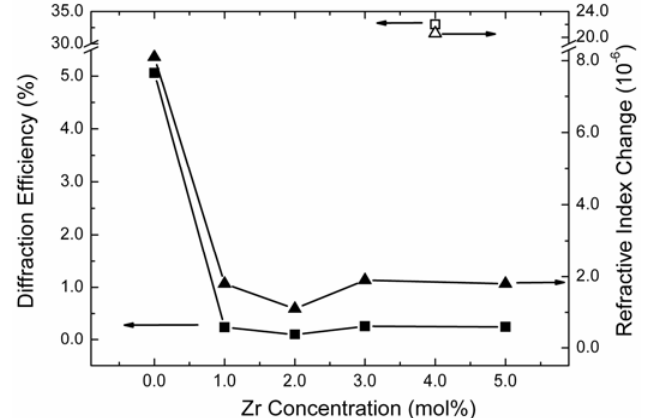
Figure 2. The Dependence of UV Photorefractive Diffraction Efficiency and Saturated Refractive Index Change of LN:Zr on the Doping Concentration of Zr. For comparison, the open symbols show the data for LN:Mg5. The lines are the guides for the eyes